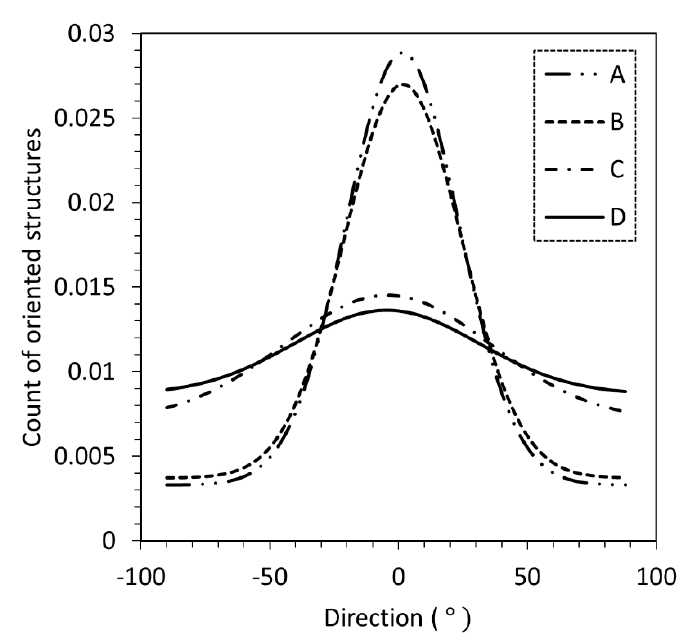
Figure 11. Particle alignment orientation obtained using image analysis ( A , B , C , D refer to suspensions listed in Table 5).